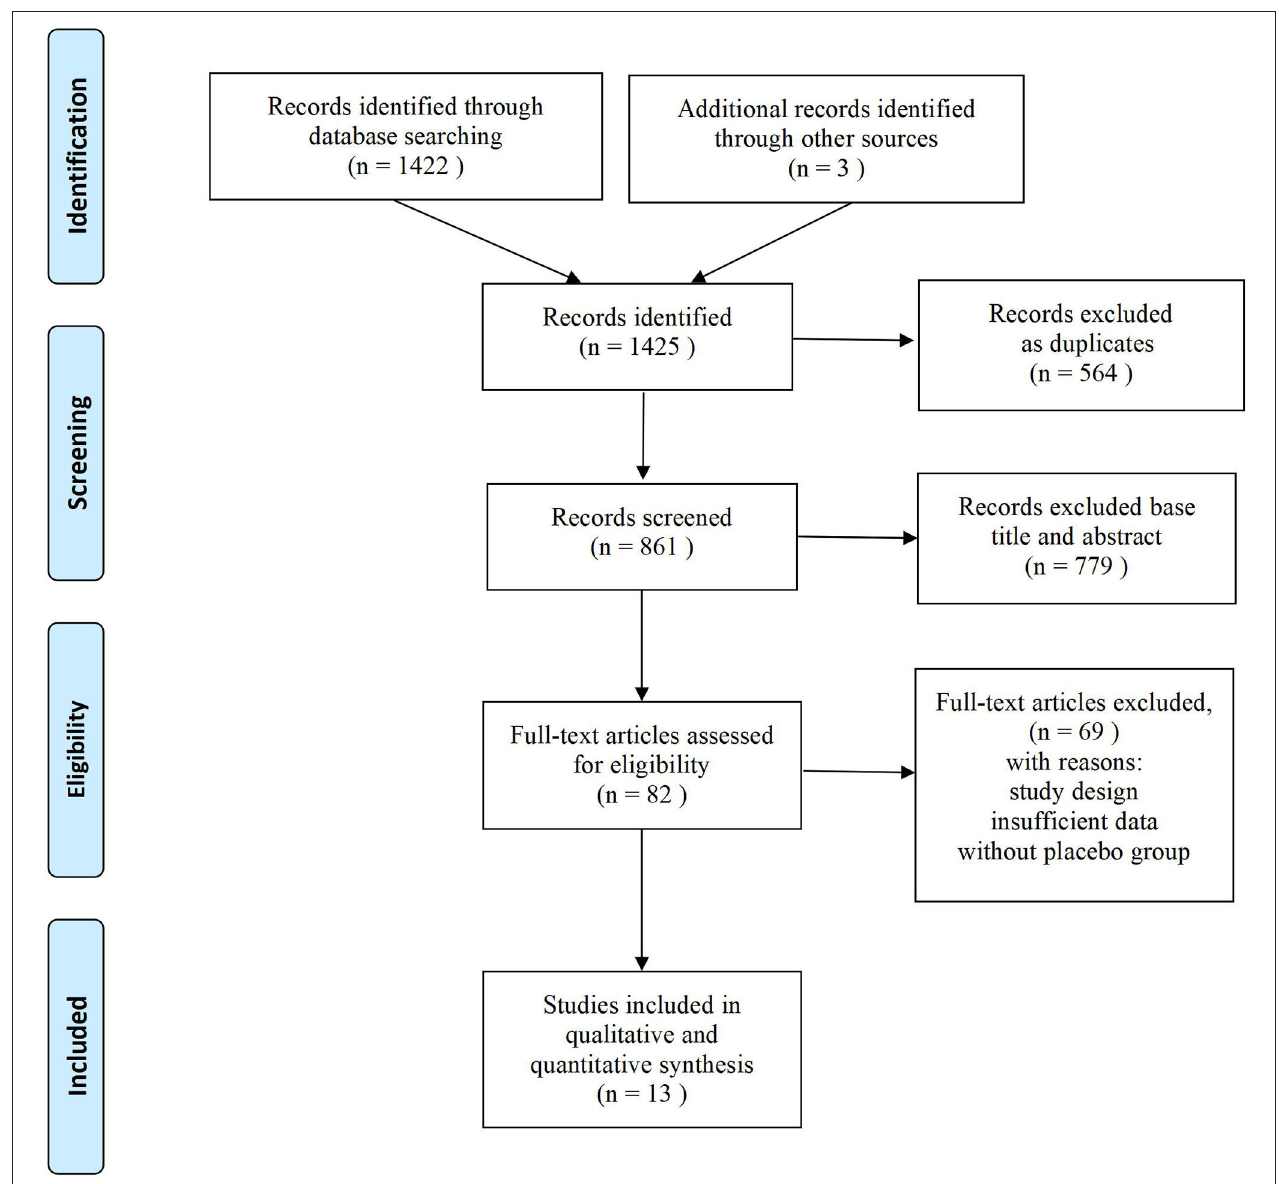
FIGURE 1 | Flow diagram of literature